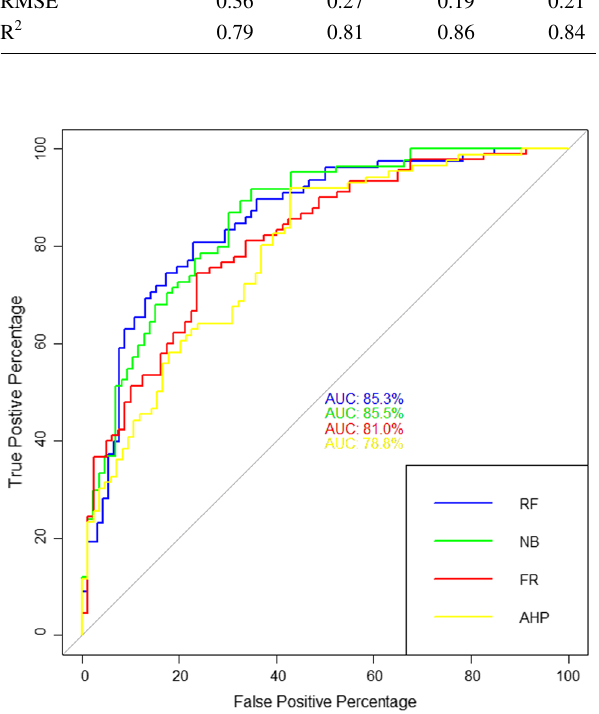
Fig. 6 ROC for models’